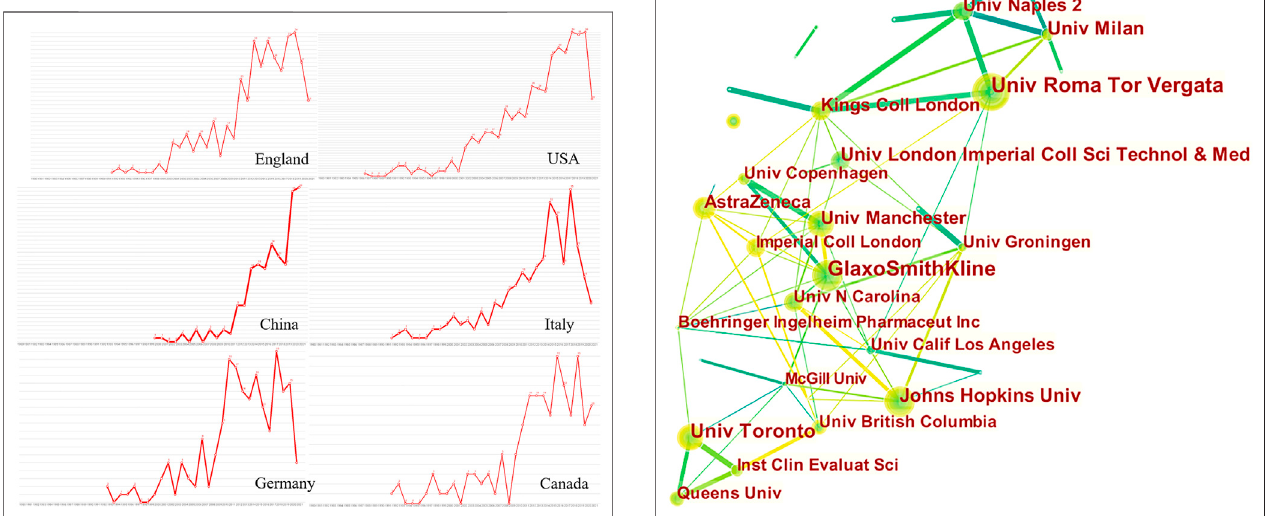
Frontiers in Pharmacology |